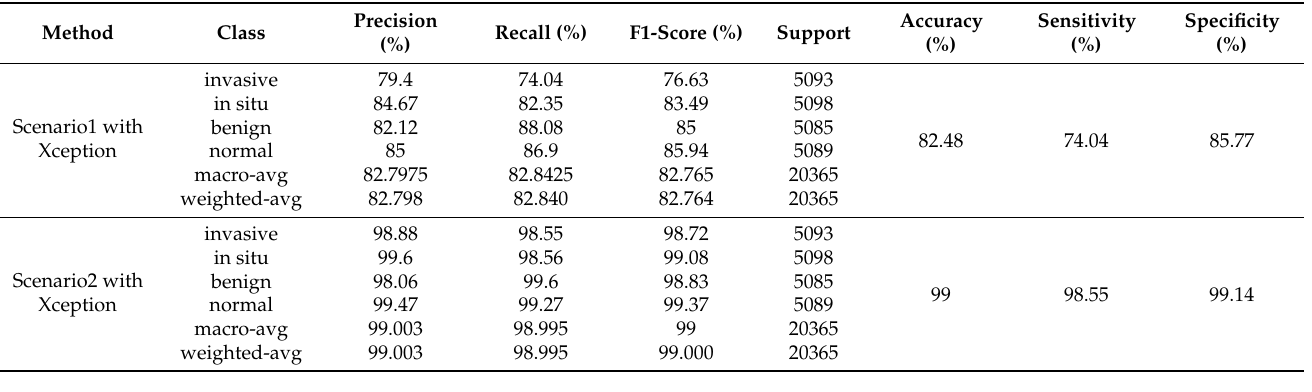
Figure 18. Learning curves of the scenarios: ( a ) Scenario1; ( b ) Scenario2 for breast cancer classification with data augmentation. Table 7. Results of Scenario1 and Scenario2 for the breast cancer classification task on dataset ICIAR2018.